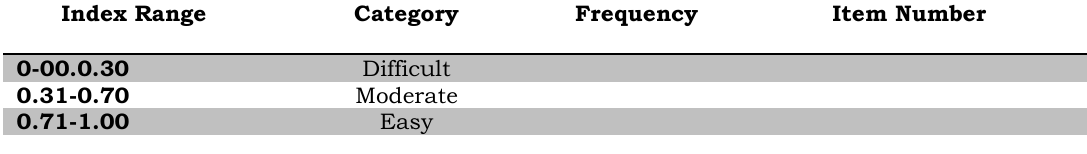
Table 1. The Category of Level of Difficulty (LD) of the Test